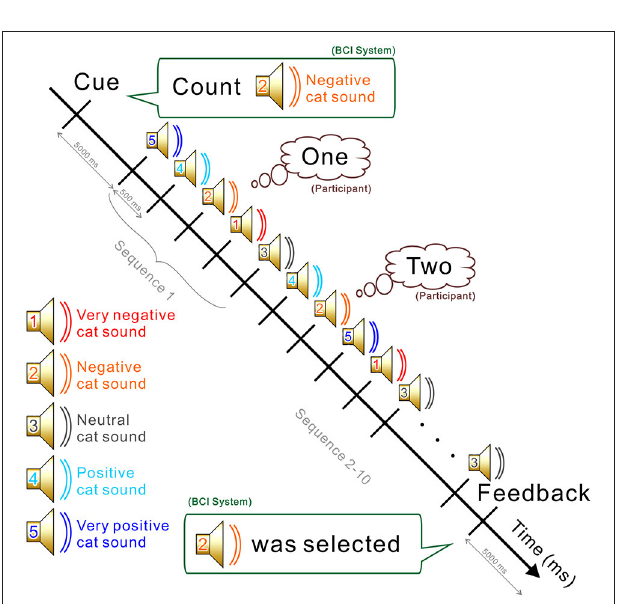
FIGURE 2 | Procedure and the mental task used during a run. The BCI system first asks the participant to count the appearance of a sound (e.g., 2: negative cat sound). All five sounds are then presented in a pseudo-random order. Participants are required to count silently when the designated sound is emitted. At the end of the run, the system estimates which sound was counted based on the EEG signal recorded during the task. The estimated output was fed back to the subject only in the test